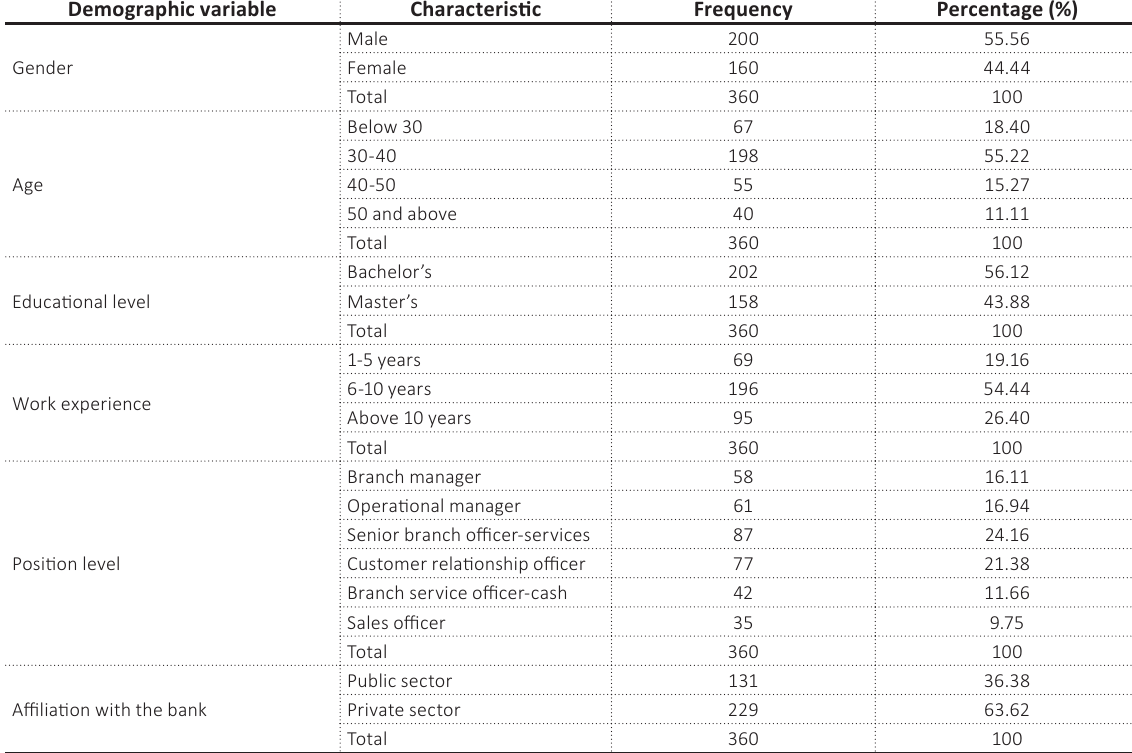
Table 1. Demographic distribution of